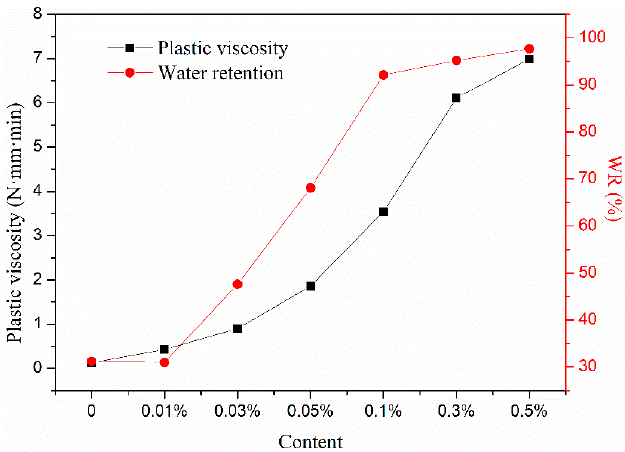
Figure 4. E ff ect of HPMC on plastic viscosity and water retention of cement mortar. Figure 4. Effect of HPMC on plastic viscosity and water retention of cement mortar.